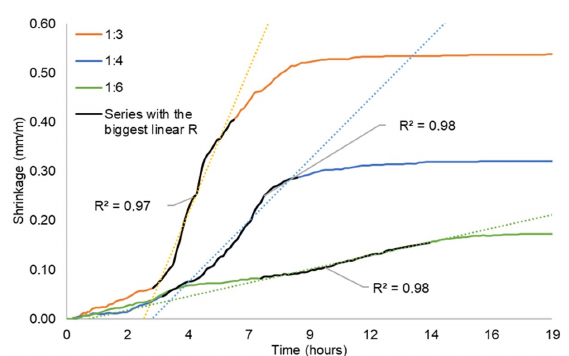
Figure 10. Average early shrinkage curves of exposed to air samples and their selected series for shrinkage speed calculation. NOTE: time scale of the graph used in 19 hours to improve the visualization of the selected series for calculating the intermediate stage’s slope. The dotted lines represent the linear trend line taken from the series with the highest linear R within the intermediate